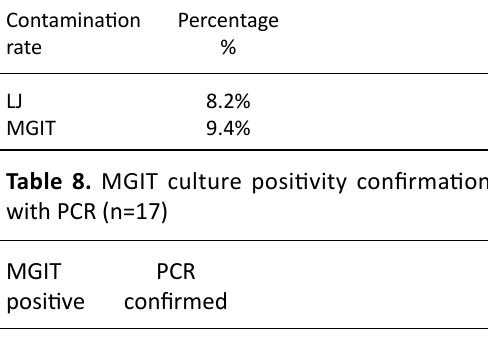
Table 6. Comparison of LJ and MGIT culture positivity Table 7. Contamination rate in MGIT and LJ culture